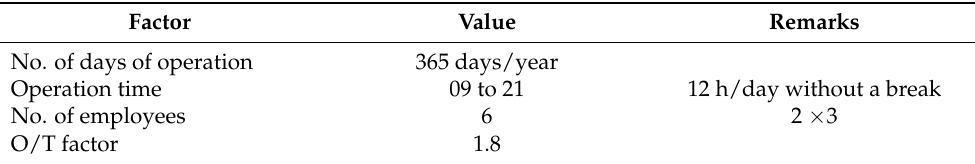
Table 46. Factors and their values are subject to the operation plan.